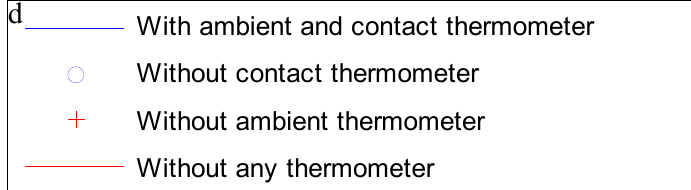
Figure 3. Temperature compensation depending on the measurement process: correction error of the cases described in Table 3 (the first case of Table 3 is the reference); ( a ) Effect of the ambient temperature variation at the moment of measuring the masterpiece ( T a, 0 ). ( b ) Effect of the ambient temperature variation at the moment of inspecting the m -th part ( T a,m ). ( c ) Effect of the temperature of the m -th part ( T m,m ) variation. ( d ) Legend of the results from using each case of Table 3.